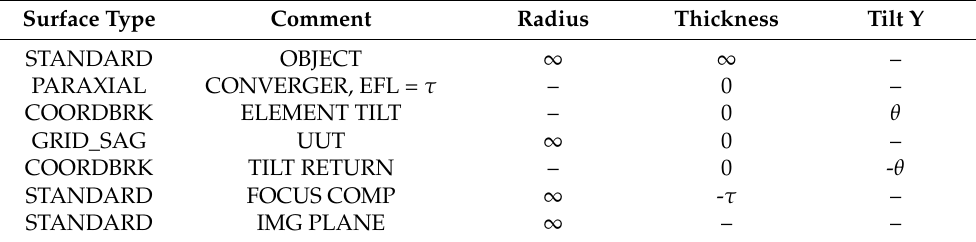
Table 6. Zemax Prescription used to Generate DENC/DENSQ Data. Variable Paraxial Converger Effective Focal Length (EFL) = τ , Variable Surface AOI = θ